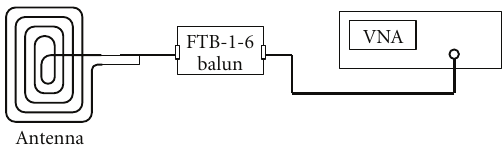
Figure 6: Measurement set